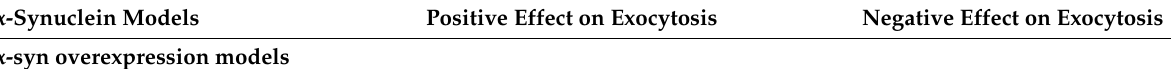
Table 4. Fine deregulation of α -synuclein ( α -syn) in exocytosis. In the table are presented divergent studies describing the role of α -syn as inhibitor or promoter of SV exocytosis. The studies are classified according to the models used and include in cellulo or in vivo α -syn overexpression and α -syn knockout models, as well as in vitro models using recombinant α -syn or artificial membrane vesicles and